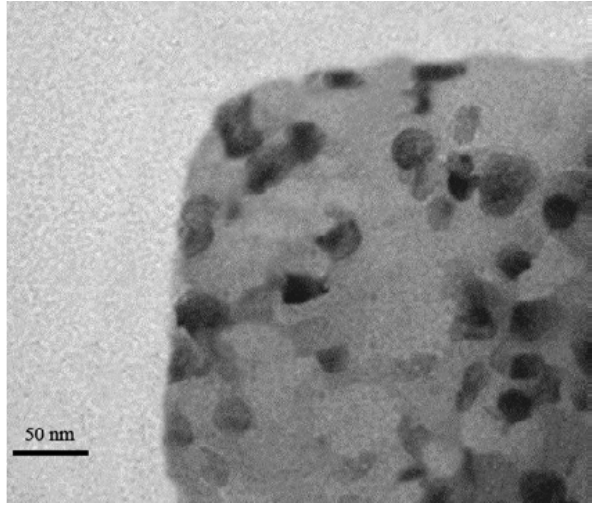
Fig. 2. TEM image of NiO/ZSM-5.